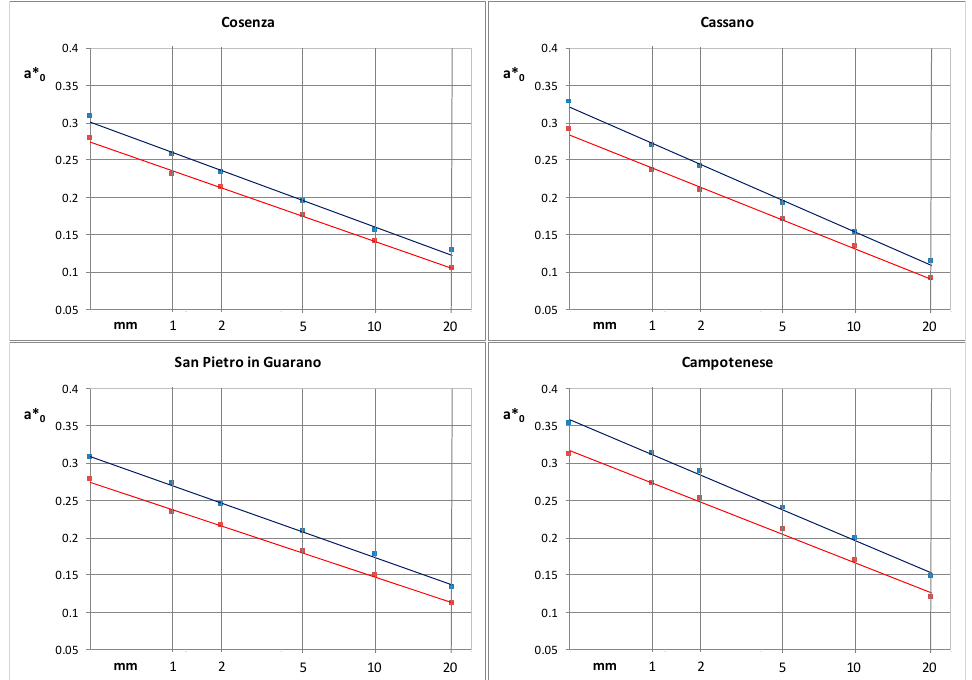
Figure 4. Behaviour of the Fourier parameter 𝑎 (cid:2868)∗ for the different threshold values. The values in blue and red refer to 1951–1980 and 1981–2010 sub-periods, respectively. The ticks evidenced on the x-axis are the threshold values, expressed by the equation ln(1+ h s ).